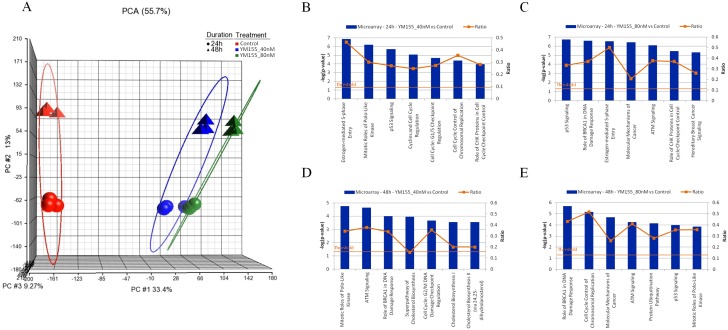
Microarray analysis on RCC786.0 cells treated with 40nM or 80nM of YM155 for 24 h or 48 h.(A) PCA clustering analysis of the results showed significant differences between treated and control cells. No significant difference was observed between the triplicate runs for each treatment arm indicating good reproducibility. Cells treated for 24 h and 48 h showed different gene expression profiles. Cells exposed to different concentrations of YM155 did not show significant differences in gene expression at either time point. Analyses were carried out on Partek (Partek Inc., Missouri, USA). Graphical representation of the top canonical signaling pathways in YM155-treated RCC786.0 cells that were significantly affected in the presence of (B) YM155, 40 nM, 24 h; (C) YM155, 80 nM, 24 h; (D) YM155, 40 nM, 48 h; and (E) YM155, 80 nM, 48 h.